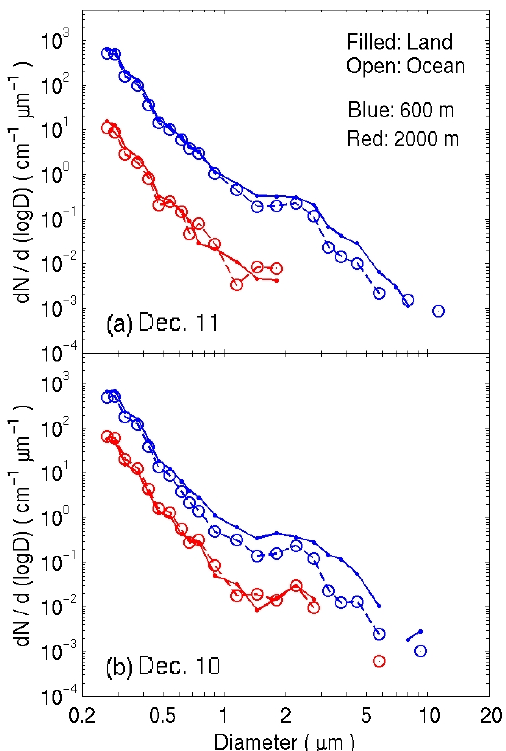
Figure 6. The particle size distributions at 600 m (blue) and 2000 m (red) off Gangneung (land) and East Sea (Ocean) on ( a ) 11 December and ( b ) 10 December. The filled and open symbols represent the aerosols obtained from land-legs (Gangneung) and ocean-legs (over the East Sea).